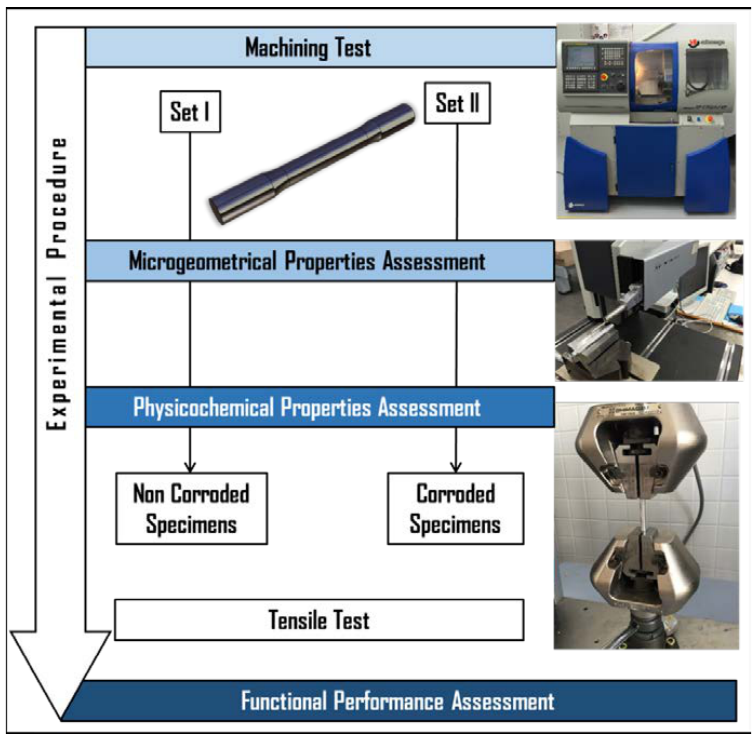
Figure 1. Experimental methodology scheme.